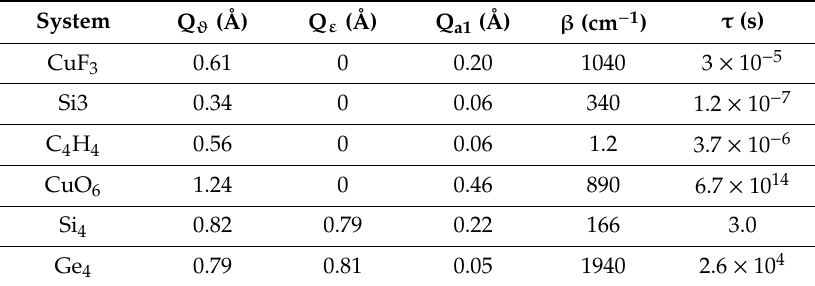
Table 1. h -PJTE-induced HS-LS e -mode Q ϑ , Q ε , and totally symmetric Q a1 distortions, the energy barrier β (read o ff the vibrational zero-point energies), and lifetimes τ at low temperatures (T =